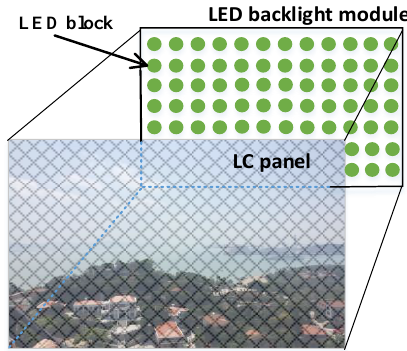
Figure 1. A local dimming system. LED: light emitting diode; LC: liquid crystal.